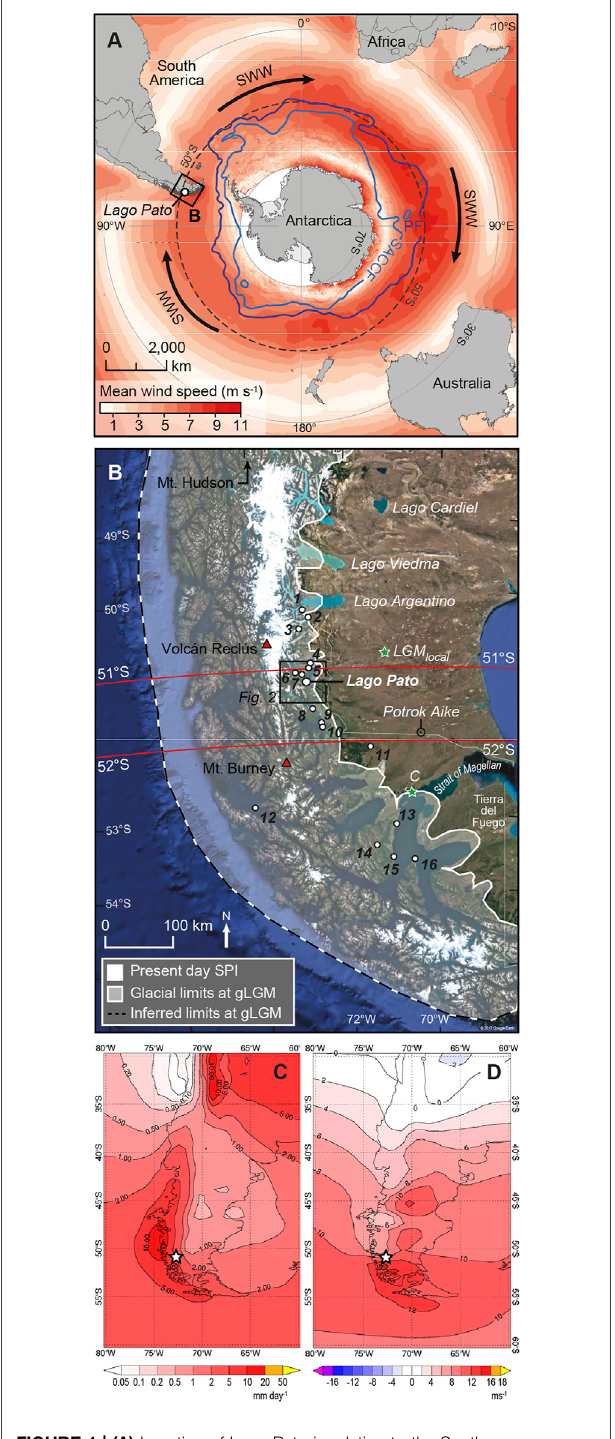
FIGURE 1 | (A) Location of Lago Pato in relation to the Southern Hemisphere Westerly Winds (SWW), the Southern Antarctic Circumpolar Current Front (SACCF), and the Polar Front (PF). (B) Location of Lago Pato, the extent of the global-Last Glacial Maximum (g-LGM) South